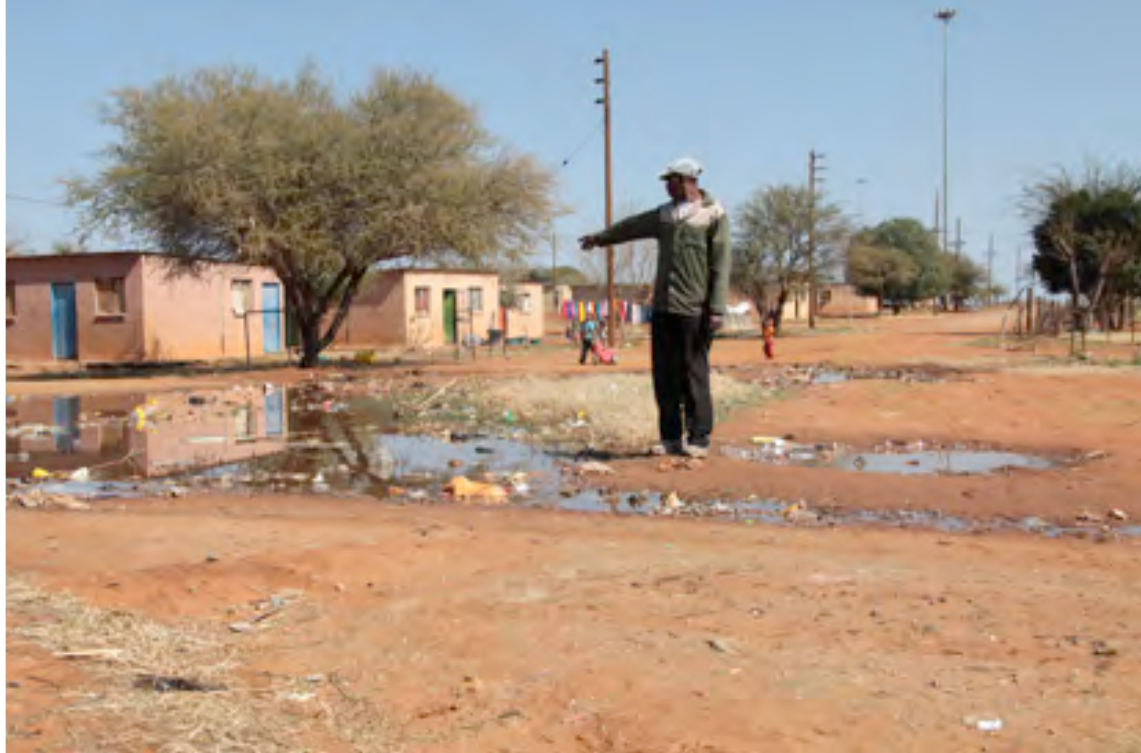
Figure 6 At the intersection of Kangulu Street in Platfontein’s Xun area water is still dammed up, despite a recent water pipe repair operation. Motorists and pedestrians are unable to pass safely through the area (Photograph: JWN